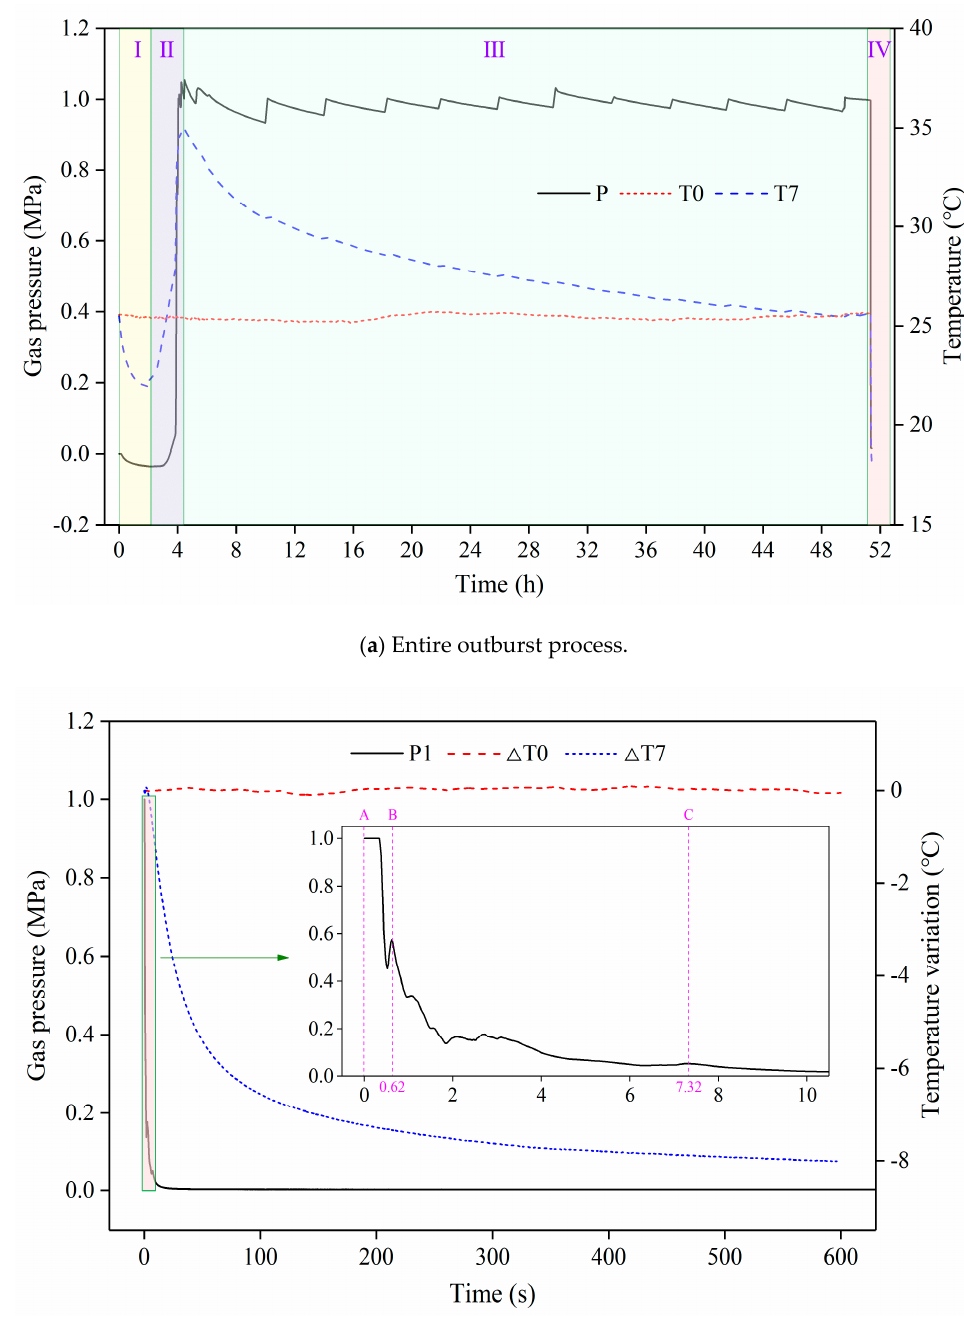
Figure 5. Gas pressure and temperature evolution during the outburst process. Figure 5b shows that the gas pressure near the outburst mouth dropped faster than the coal temperature, and the gas pressure curve exhibits multiple local peaks. For example, P1 falls to 0.452 MPa at 0.52 s after the outburst trigger, after which it rises to 0.576 MPa at 0.62 s, and subsequently drops again. After the outburst mouth opened, the stress of the coal in the Z direction changes from